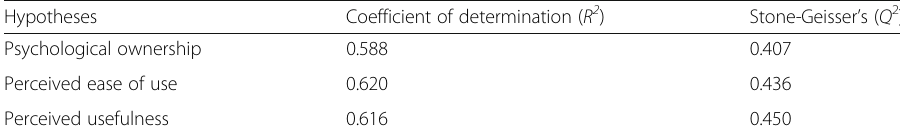
Table 3 Coefficient of determination and Stone-Geisser ’ s index of endogenous constructs